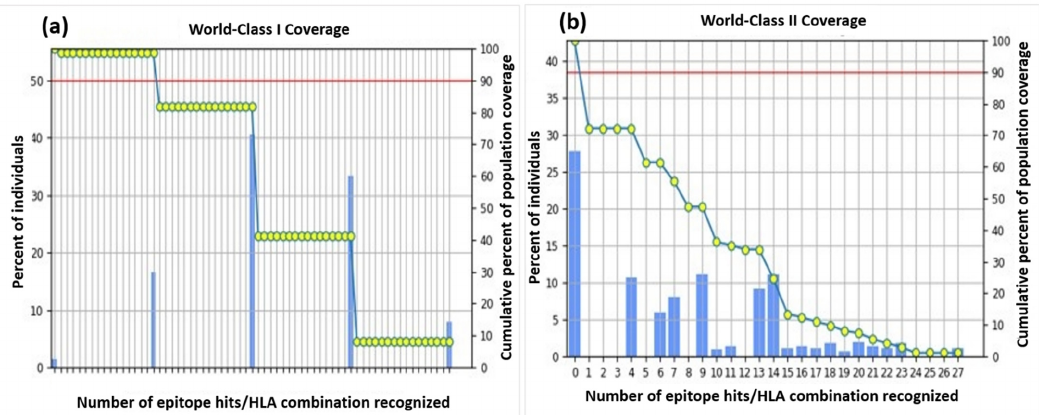
Figure 2. Population coverage of all the selected epitopes for both MHC-II classes. ( a ) World-Class I Coverage. ( b ) World-Class II Coverage.